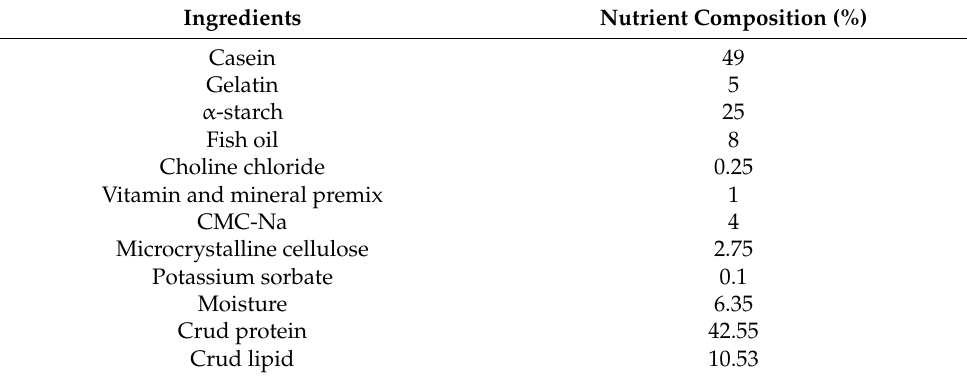
Table 3. Statistical table of assembly-result